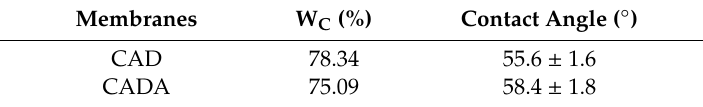
Figure 9. A snapshot of the contact angle of prepared membranes: ( a ) CAD and ( b ) CADA membranes. Table 4. Water content and contact angle of as-prepared membranes.